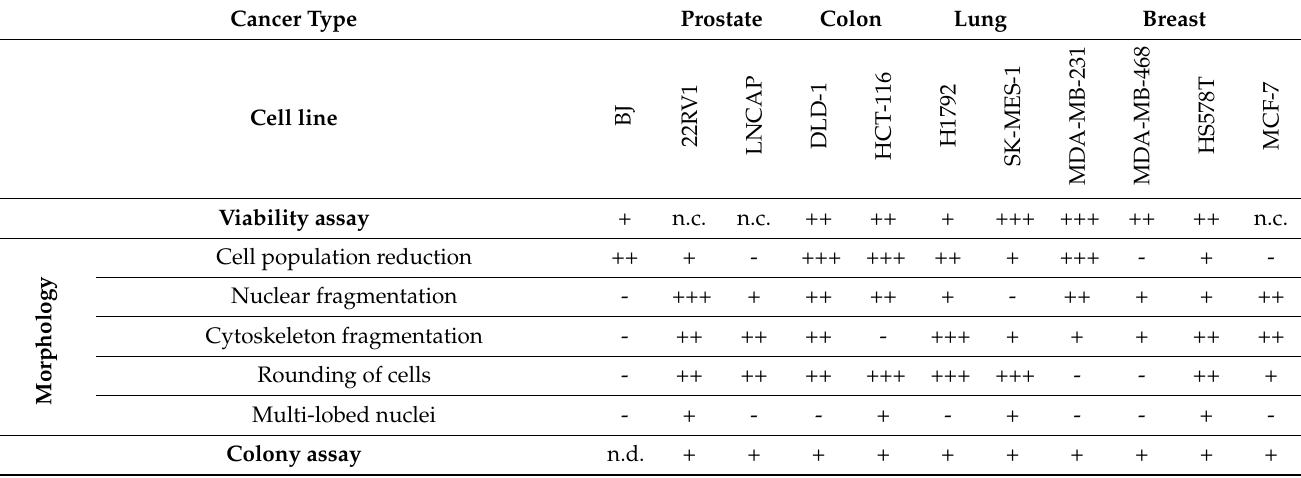
Table 3. Summary of the in vitro effects of Leontopodium alpinum treatment on the investigated cell